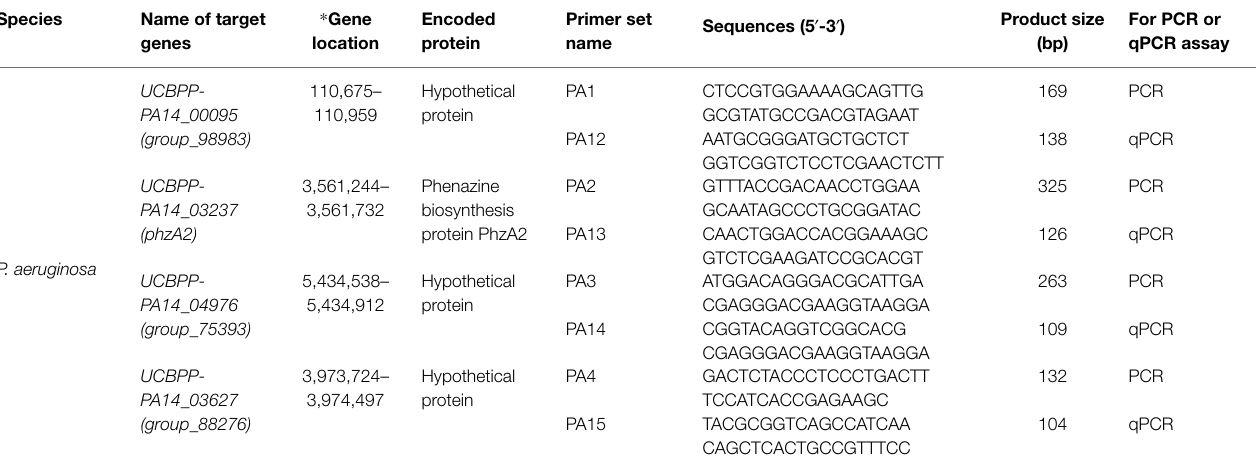
TABLE 1 | Species-specific genes and primers for PCR and qPCR identification of P. aeruginosa .